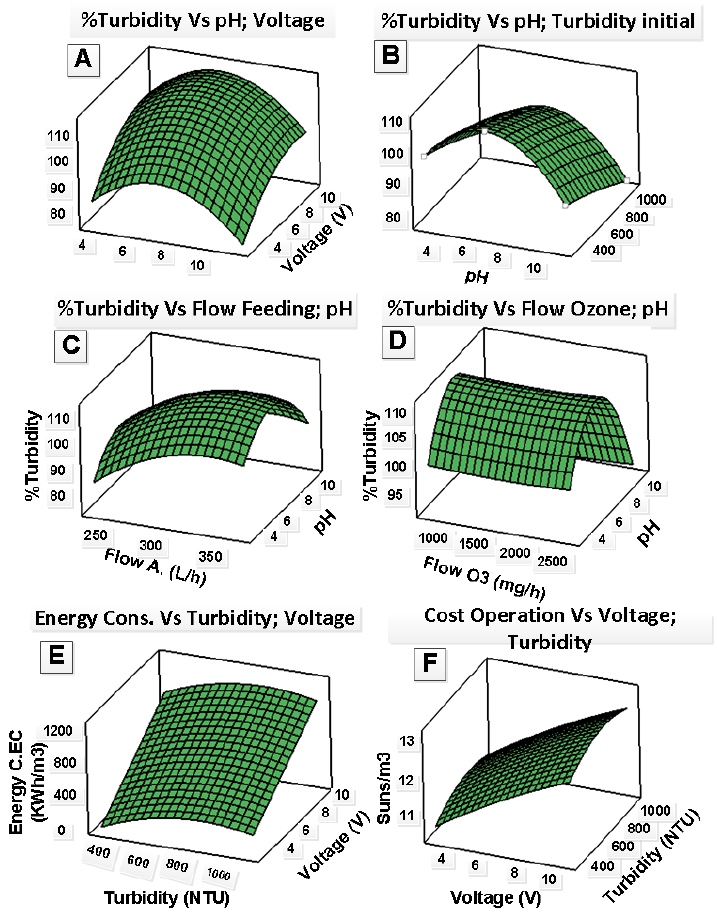
Figure 5. Representation of the effect of operational variables on % reduction in turbidity, energy consumed in the electrolytic cell, and operational cost of the module. ( A ) Variation of the pH and voltage variables against % turbidity for fixed values of 300 L/h, 752.5 NTU, and 1650 mg/h. ( B ) Variability of pH and initial turbidity versus % turbidity for fixed values of 6.5 volts, 300 L/h and 1650 mg/h of O 3 flow. ( C ) pH and feed flow variability versus % turbidity for fixed values of 6.5 volts, 752.5 NTU, and 1650 mg/h O 3 flow. ( D ) Ozone and pH flow variability versus % turbidity for fixed values of 6.5 volts, 300 L/h, and 752.5 NTU. ( E ) Variability of initial turbidity and voltage versus energy consumption in the electrocoagulation cell for fixed values of 300 L/h, 7.4 pH, and 1650 mg/h of O 3 flow. ( F ) Variability of voltage and initial turbidity against the cost of the built module for fixed values of 300 L/h, 7.4 pH, and 1650 mg/h of O 3